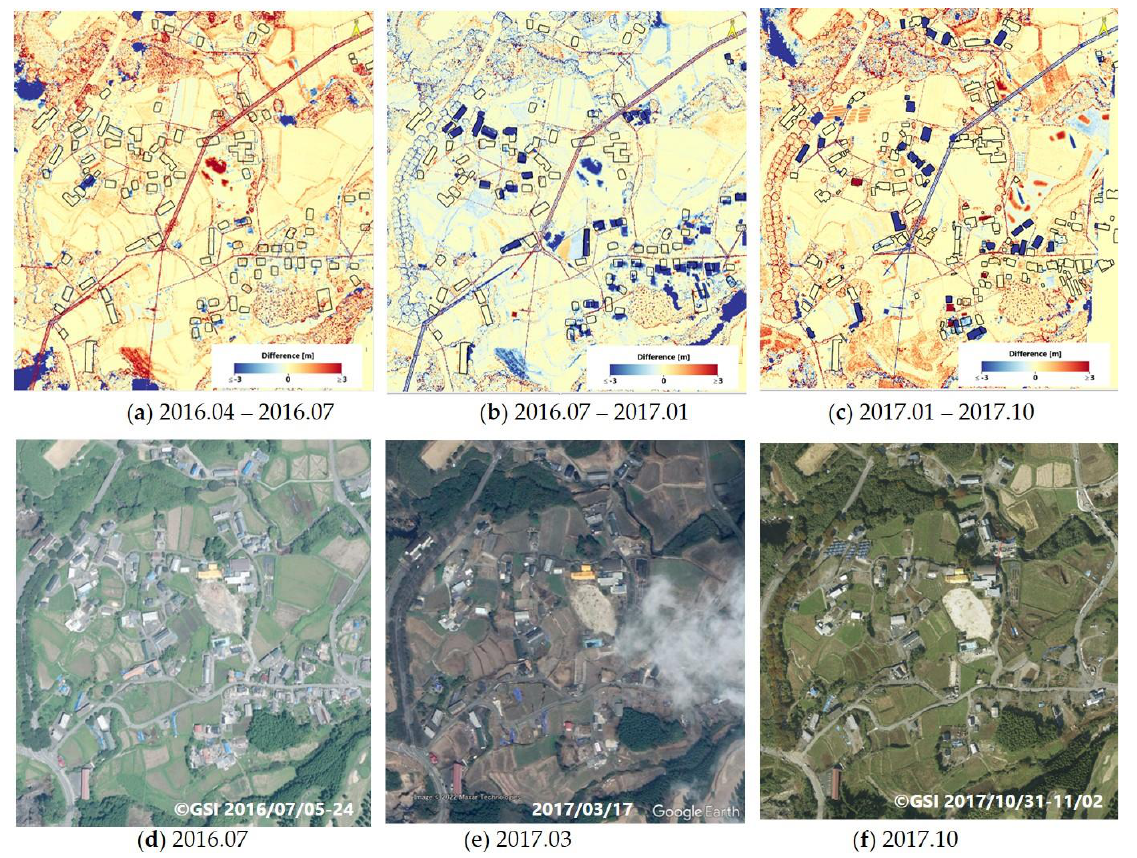
Figure 15. DSM difference for Kawayo district in the three periods after the earthquake ( a – c ), and the optical images (the close-ups of Figure 4) on three corresponding dates ( d – f ). The color chart of the DSM differences is the same as that in Figure